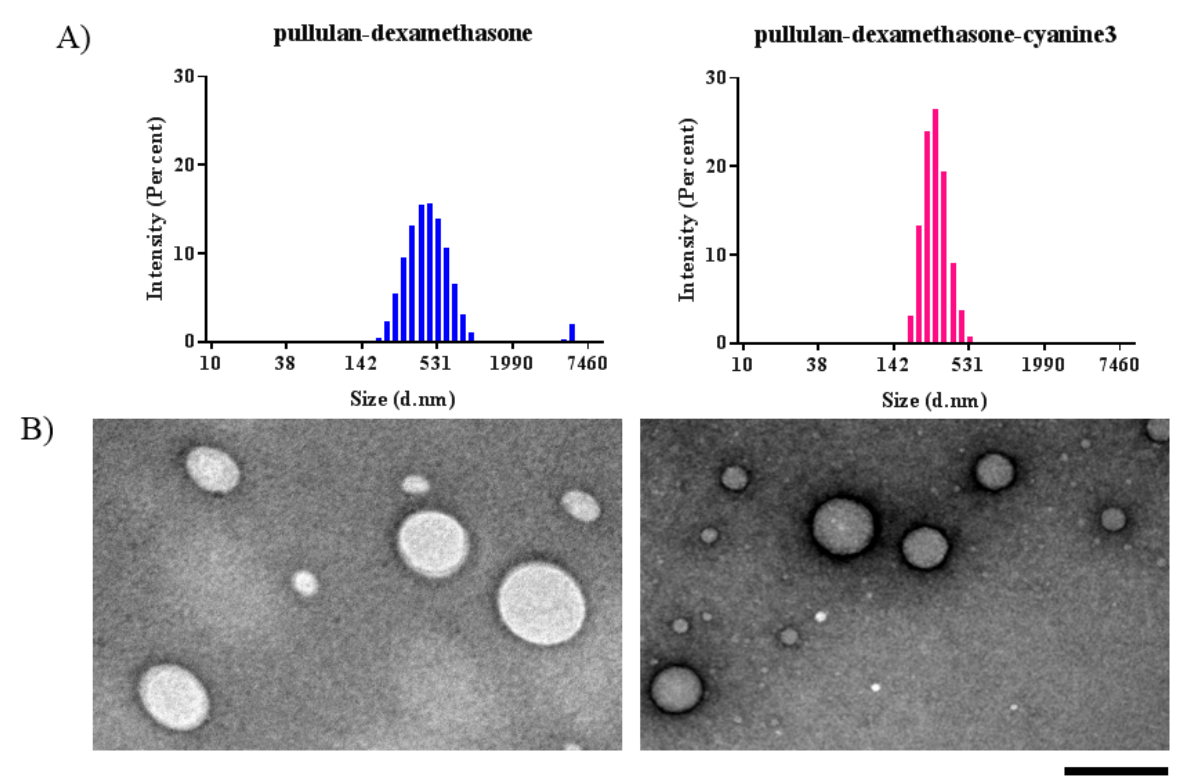
Figure 3. ( A ) Size distribution profile by intensity of pullulan-dexamethasone ( ■ ) and pullulan-dexamethasone-cyanine3 ( ■ ). ( B ) TEM images of pullulan-dexamethasone ( left ) and pullulan-dexamethasone-cyanine3 ( right ). Bar size: 500 nm.